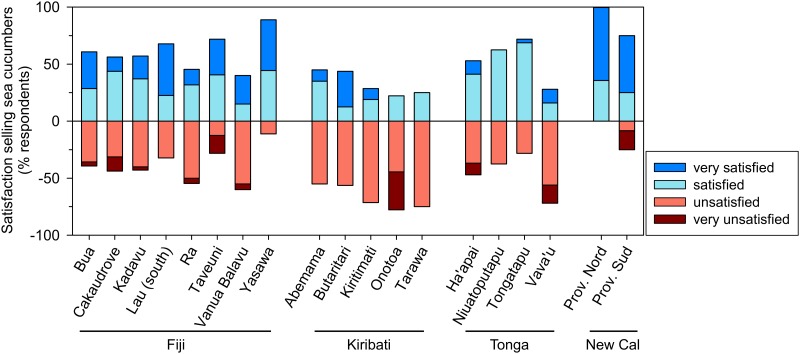
Fishers’ satisfaction with income from fishing and selling sea cucumbers.Fishers were asked how satisfied they were income they gained from fishing and selling sea cucumbers, and to respond according to one of four categories (see legend). Bars represent the proportion of fishers in each location who replied according to the satisfaction categories.